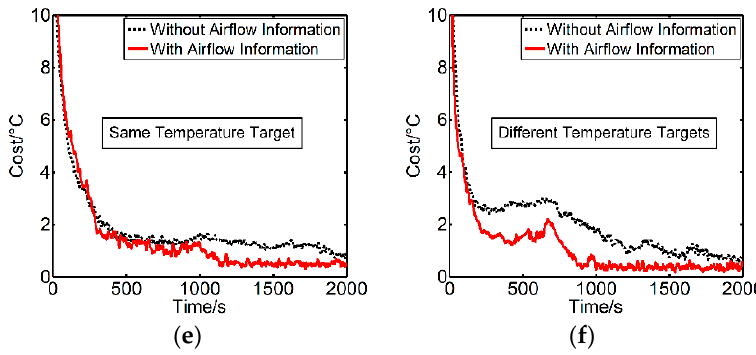
Figure 10. The control effect comparison when taking temperature only as input and taking airflow speed and temperature as input. ( a , b ) Temperature signals with airflow information when setting the same or different temperature targets. ( c , d ) Temperature signals without airflow information when setting the same or different temperature targets. ( e , f ) Cost function comparison with or without airflow information.